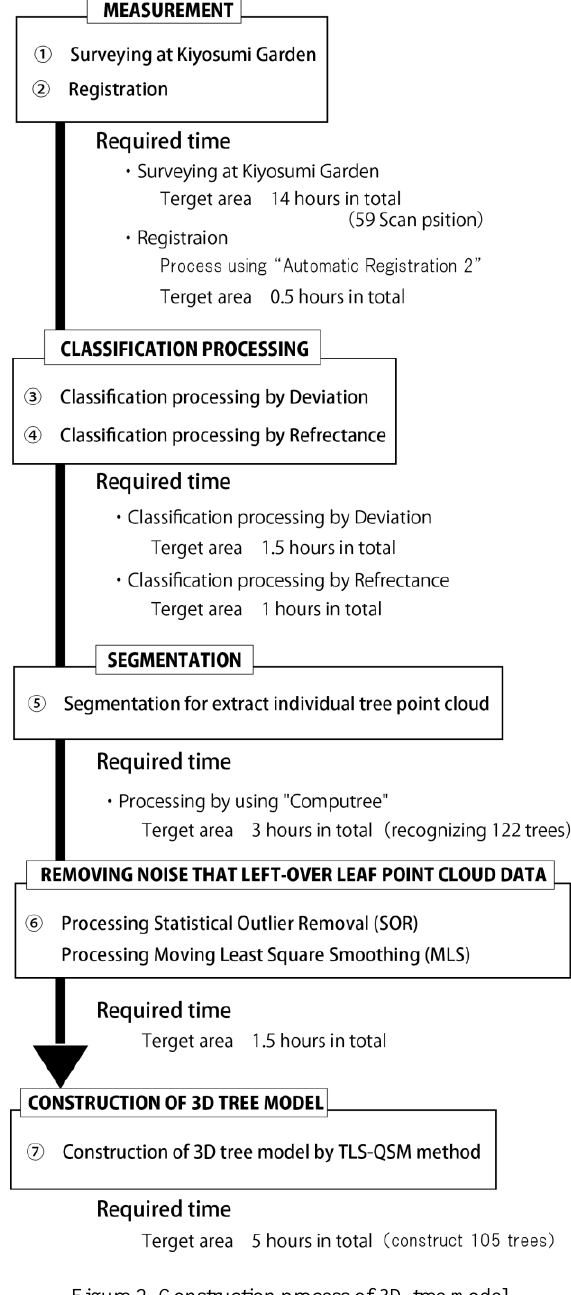
Figure 2. Construction process of 3D tree model